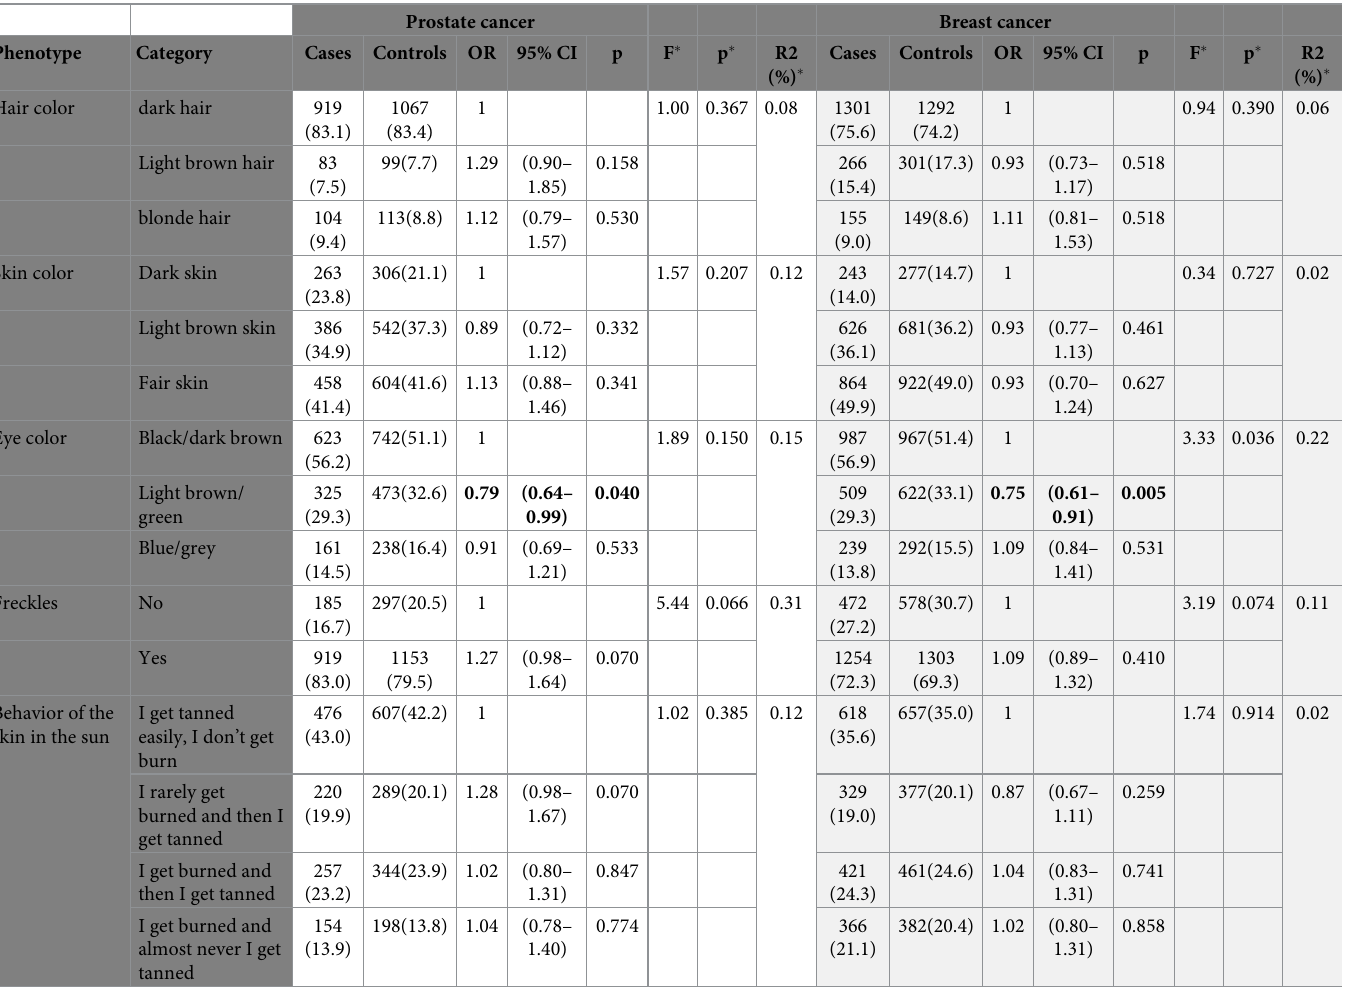
Table 1. Relationship between phenotype and prostate and breast cancer. Prostate cancer Breast